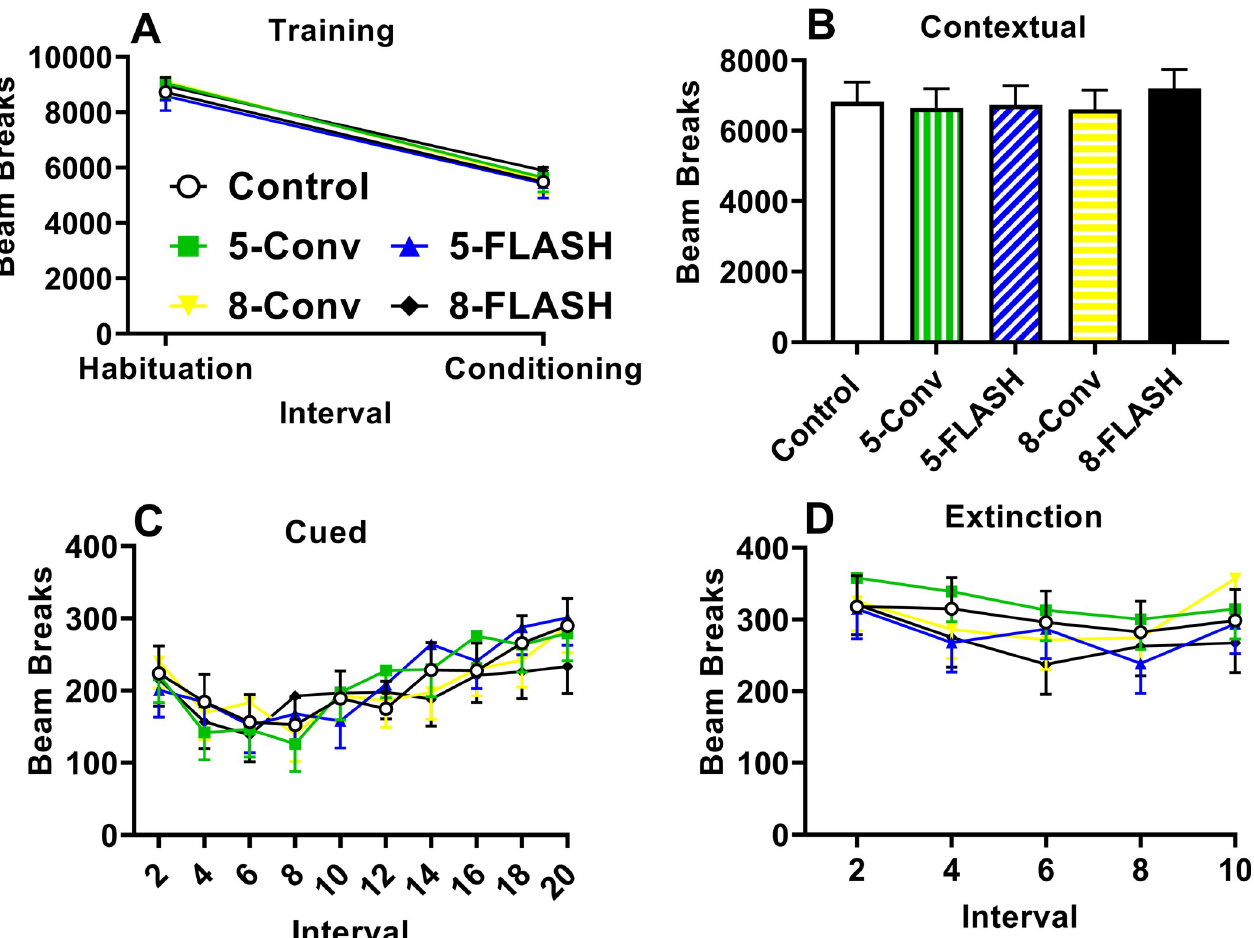
Fig 8. Conditioned freezing [beam interruptions (mean ± SEM)] for proton irradiated and control rats. A. Day 1 habituation phase and conditioning phase; there were no differences between the irradiated groups and controls. B. Day 2 contextual learning phase; there were no differences between irradiated groups and controls. C. Day 3 extinction phase for the tone on trials; no differences between groups. D. Day 4 reinstatement phase; no differences were noted. N = 16-19/exposure/sex. Several rats escaped the test arena during the conditioning phase and their data were not